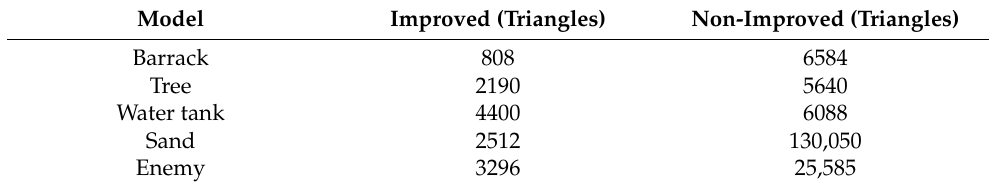
Table 1. Triangle count for some of the models in improved and non-improved versions of the game.